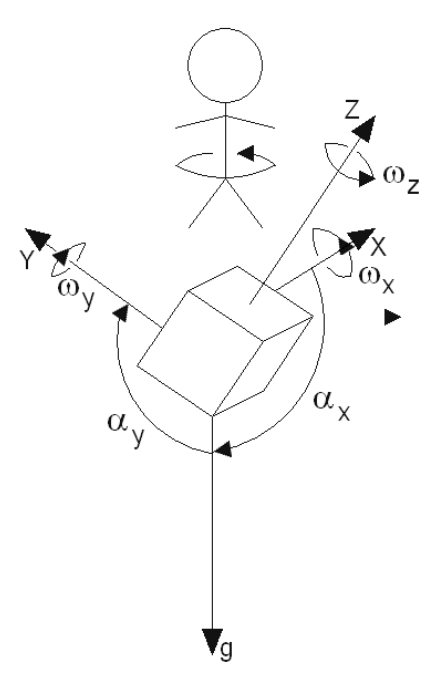
Figure 5. The local coordinate system of the 6DOF sensor. g denotes the